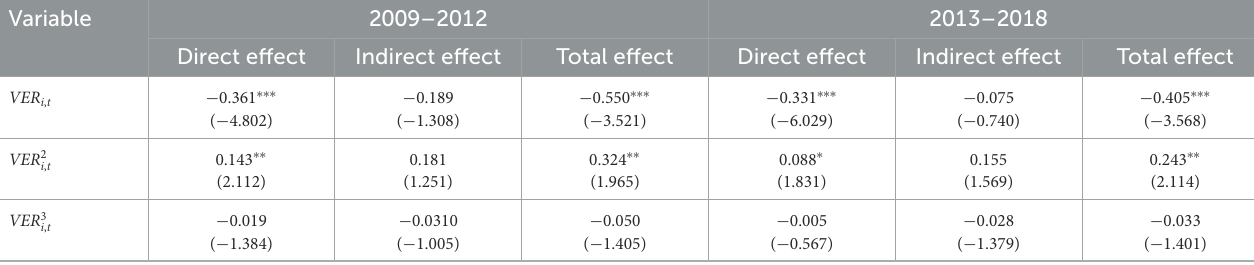
TABLE 10 Decomposition results of effects of VER on GDE in different time periods.